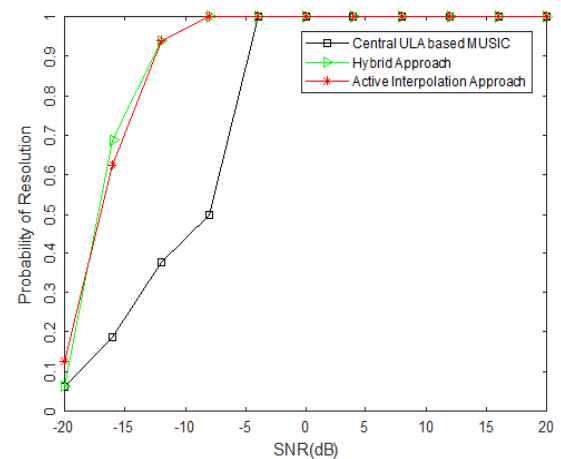
Figure 6. PR versus SNR (Snapshots = 100, K = 16 sources, I = 300 Monte Carlo Experiments).